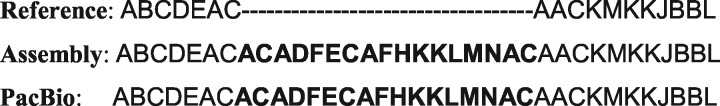
Comparison of the internal structures of a known MS1 allele, the local assembly generated by our pipeline and PacBio's global genome assembly. Bold letters indicate the missing sequence in the reference, which is recovered by our local assembly as well as PacBio’s global genome assembly